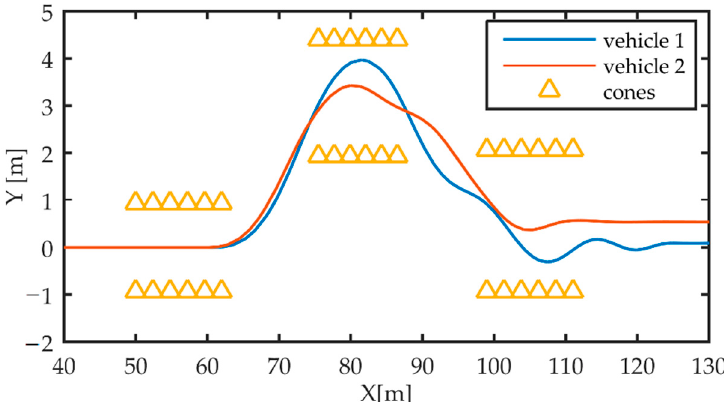
Figure 12. SLC test results: simulated path for vehicle 1 and vehicle 2 in mode 1.